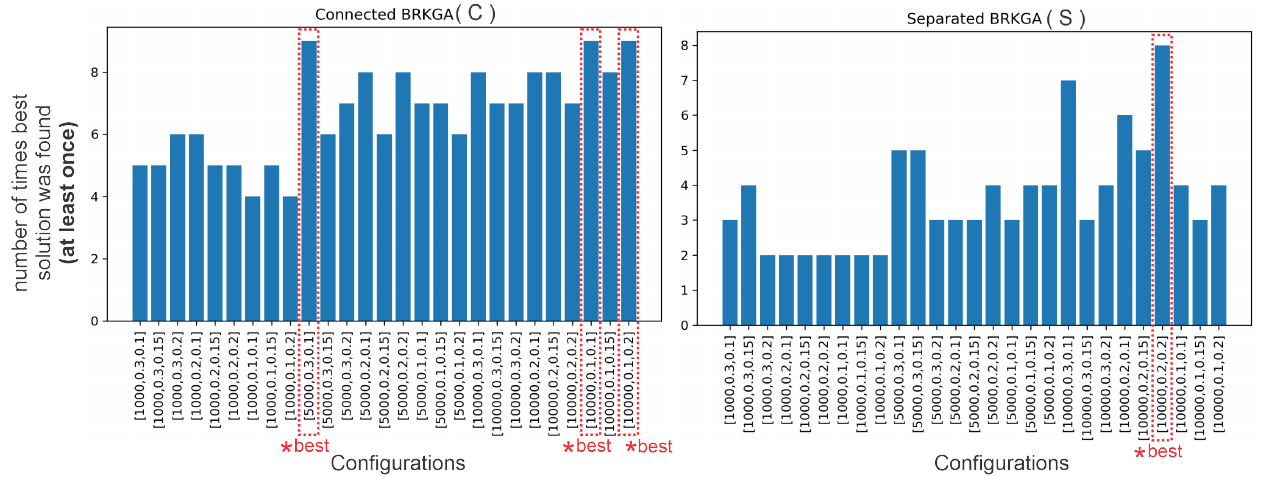
Figure 13. Analysis of the proposed configurations for BRKGA ( relation-2